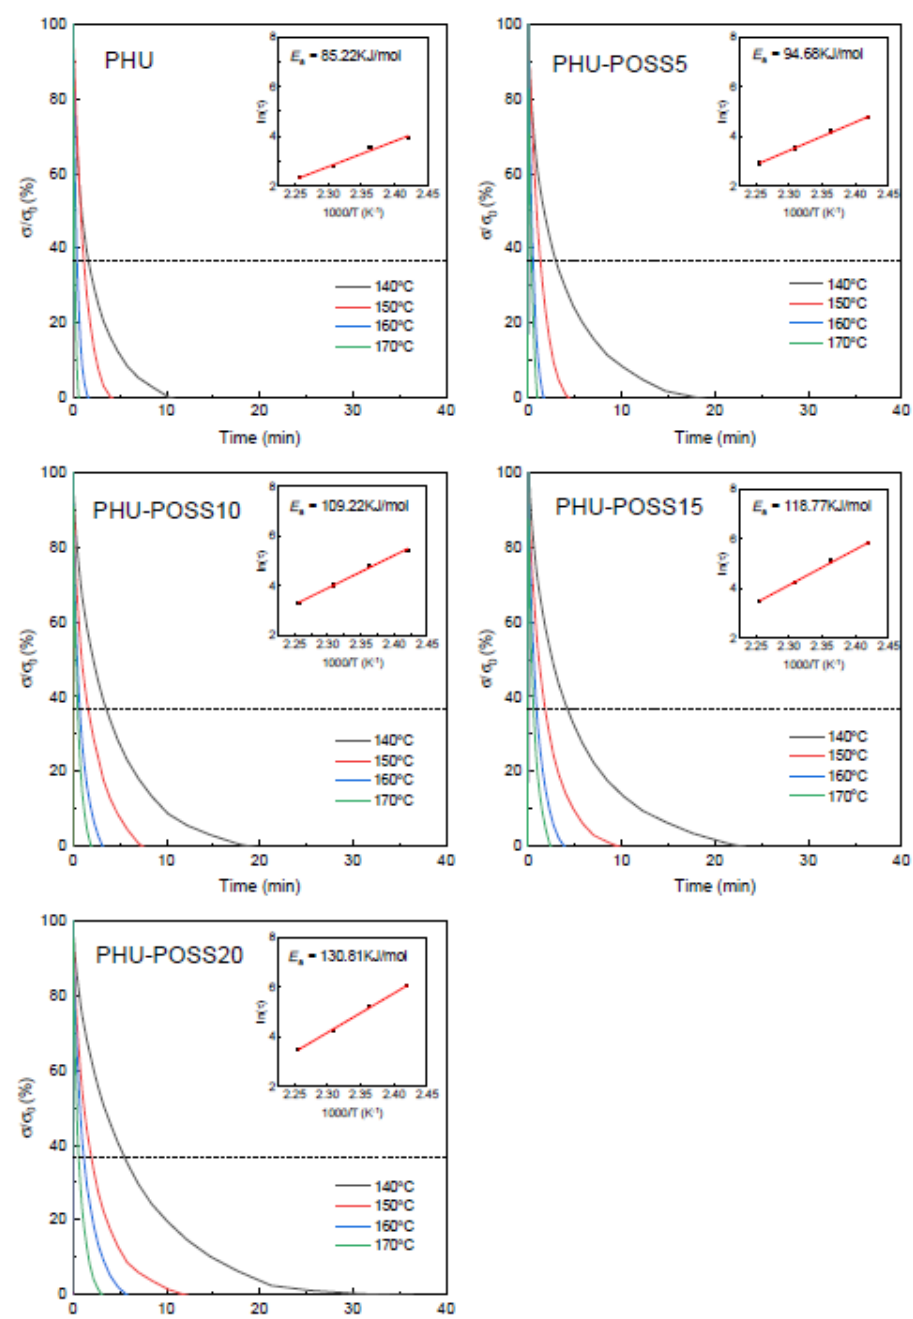
Figure 12. Stress relaxation curves of PHU and PHU-POSS nanocomposites at various tempera-